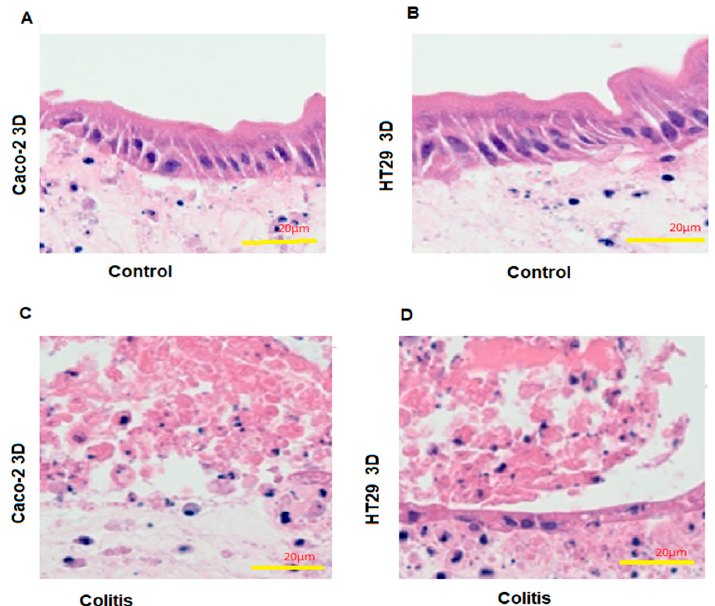
Figure 3. The manifestation in 3D-printed Caco-2 and HT-29 constructs. The 3D-printed Caco-2 and HT29 constructs were fixed in a 2% paraformaldehyde solution (10 mM calcium chloride, 50 mM sucrose in PBS) and paraffin embedded by using standard techniques. Using standard protocols, sections were stained with haematoxylin and eosin (H&E). (Scale bar: 20 µ m) Colitis manifestation was determined by viewing images under a microscope at 200 × . ( A , B ) show untreated control 3D-printed CaCo-2 and HT-29 cell constructs, whereas ( C , D ) depict a DSS-induced colitis-like condition in 3D-printed Caco-2 and HT29 cellular